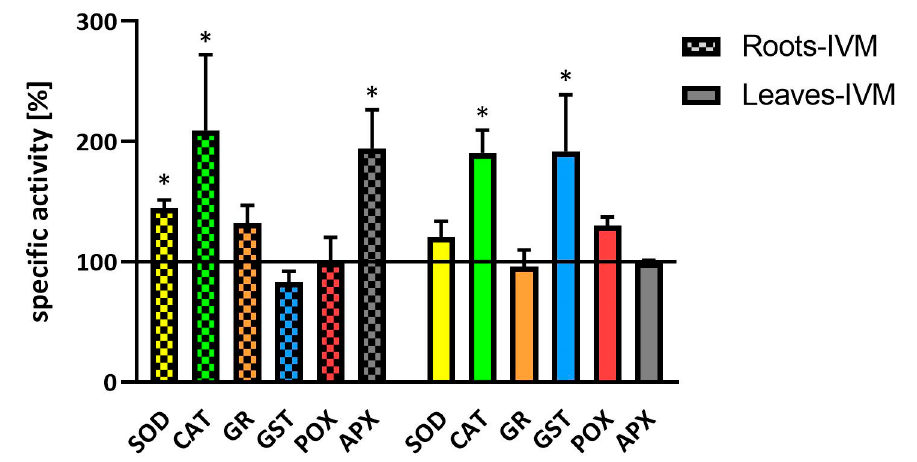
Figure 3. Specific activities of antioxidant enzymes (SOD, CAT, GR, GST, POX, and APX) in soybean roots and leaves after seven days of exposure to IVM. Data are presented as the percentage of specific enzyme activity of control plants (100%). Data are expressed as mean ± SD ( n = 4). * indicates statistically significant difference between treated and control plants.